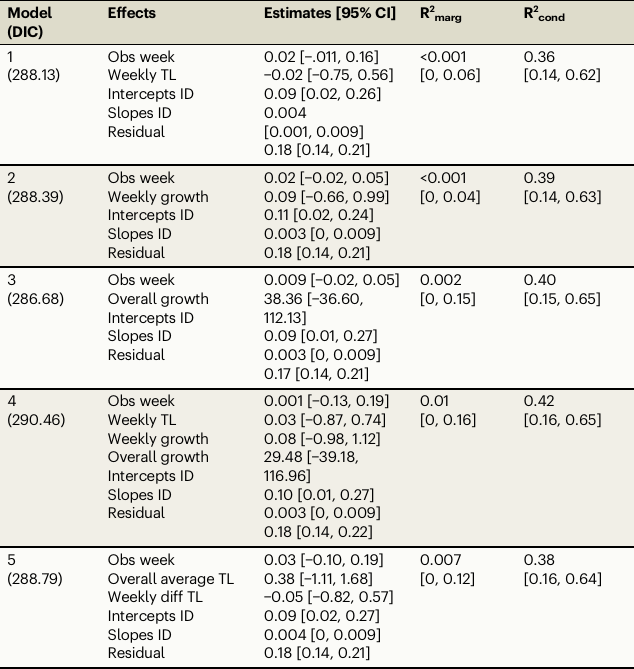
Comparisonoftheexplanatory power ofdifferent aspectsofbodysize (TL=total length)and growthratesonweeklymedianswimmingspeedbehavior.Valuesoflessthan0.001arelistedas ‘ 0 ’ .R 2 marg andR 2 cond arethemarginalandconditionalR 2 valueswhicharetheproportionoftotal behavioral variationexplained bythe fi xed effectsonly orbythe fi xed andrandomeffects combined,